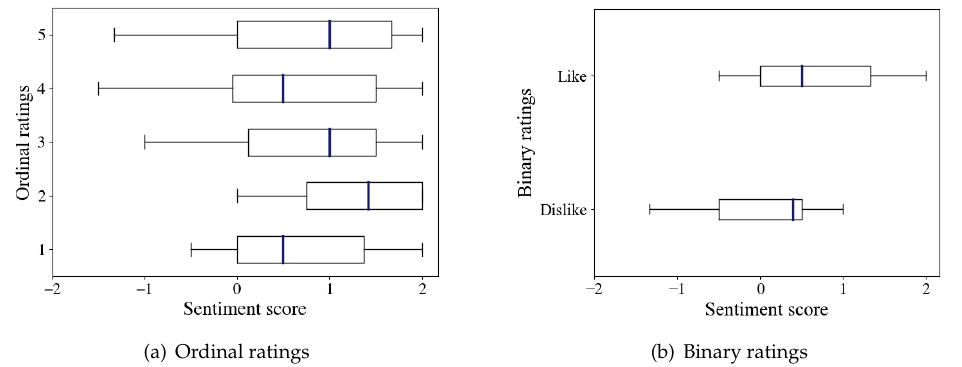
Figure 3. Boxplots representing distributions of review texts’ sentiment scores according to ( a ) ordinal ratings and ( b ) binary ratings.